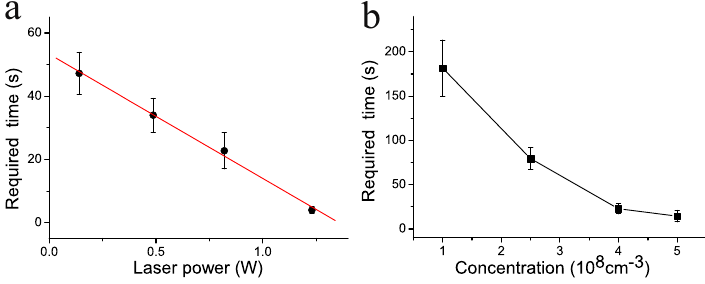
Figure 3. Confinement capabilities of diffraction traps for 1 µ m particles. ( a ) the confinement capability as a function of laser power at a particle concentration of 4 × 10 8 cm − 3 ; ( b ) the confinement capability as a function of particle concentration at laser power 820